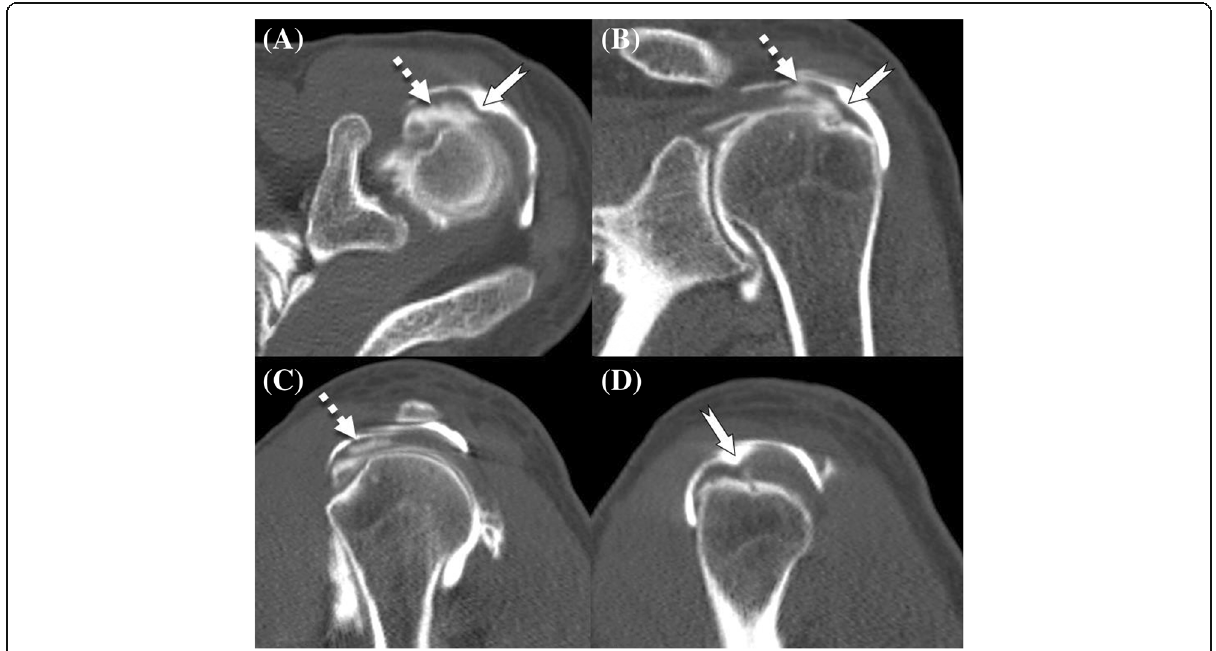
Fig. 6 A 52 years old female patient complained from left shoulder pain with some limitation of movement. Axial ( a ), coronal oblique ( b ), and sagittal oblique images ( c , d ) CT arthographic images show double partial thickness tear through the bursal (notched arrow) and articular (dashed arrow) surfaces of the supraspinatus tendon, none of which communicate with the other, excluding the presence of full-thickness defect. Note that CTA alone will miss the bursal surface component